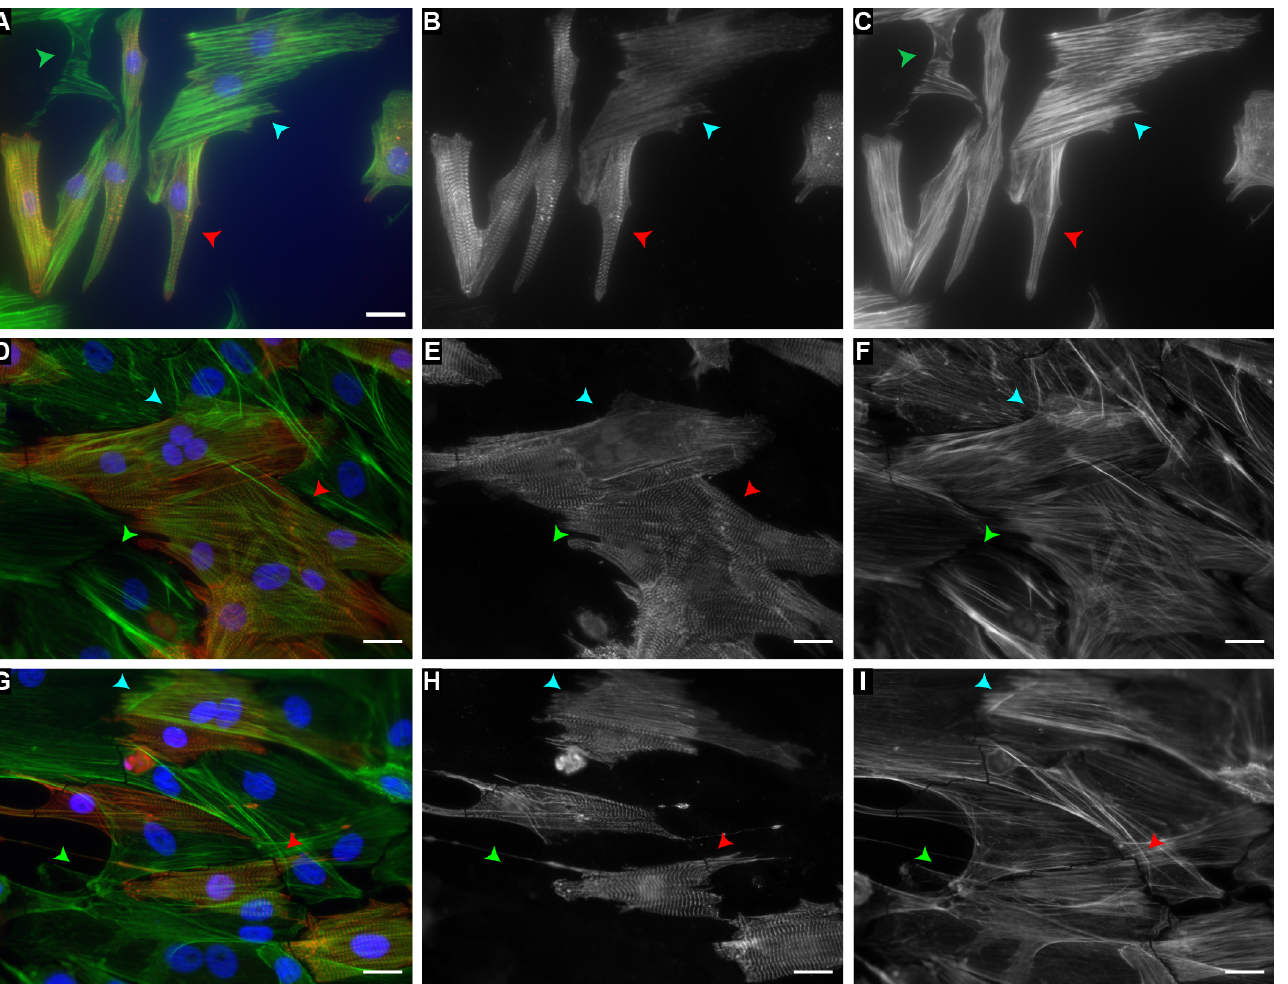
Figure A1. Co-culture of cardiomyocytes labeled with ( A , D , G ) α -actinin in red, actin in green, and DAPI in blue, ( B , E , H ) α - actinin, and ( C , F , I ) actin. In ( A – I ), the red arrowhead points to cardiomyocytes, the green arrowhead to fibroblasts, and the cyan to cells with α -actinin, but no identifiable sarcomere striations. Scale bars: 20